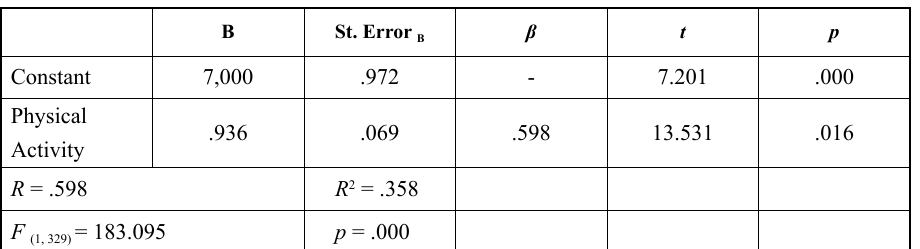
Table 2. Regression analy